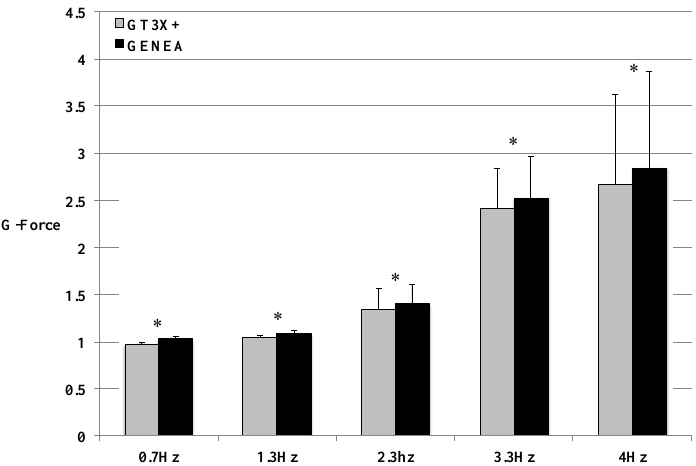
Figure 2. Comparison of the mean triaxial raw acceleration vector magnitude at four different oscillation frequencies during mechanical shaker testing. (* indicates statistically significant differences, p < 0.05. Error bars represent standard deviations).